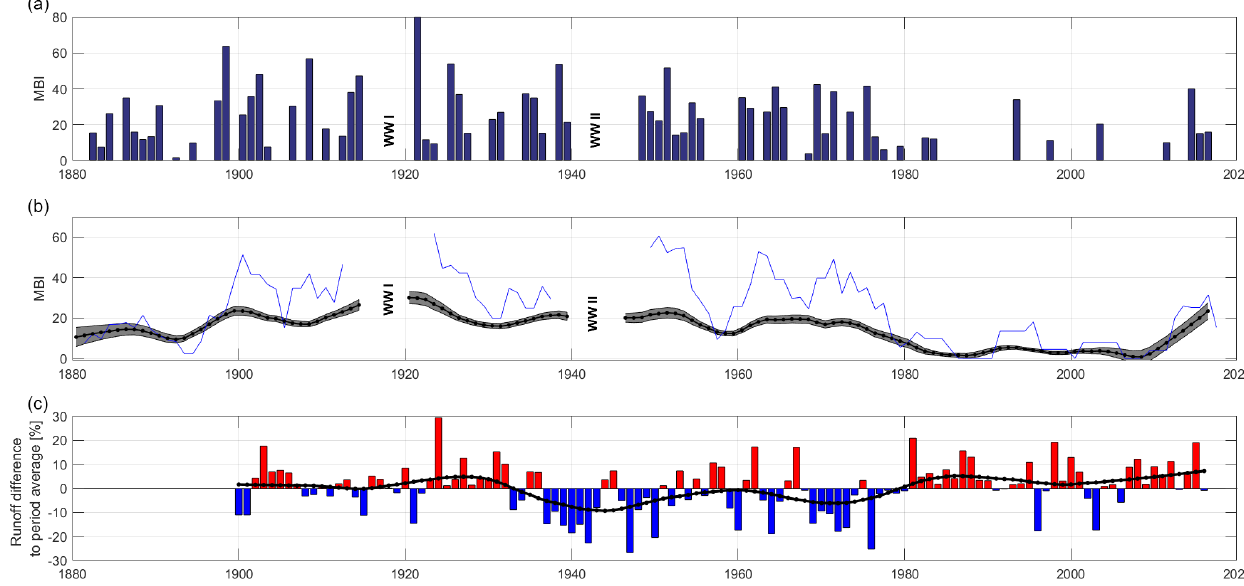
Figure 10. MBIs during 1880–2016 (a, b) . There are no data available for the World War periods of 1915–1920 (WWI) and 1940–1946 (WWII). Panel (c) shows the total river runoff to the Baltic Sea during the period 1900–2016. The unit is percent relative to the period average. Please see the text for details on data sources.